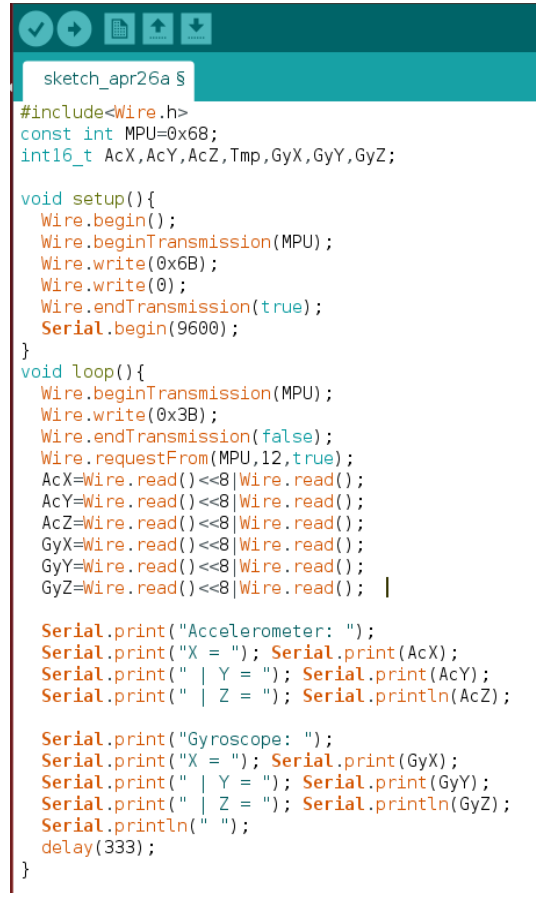
Figure 13. Code for proposed